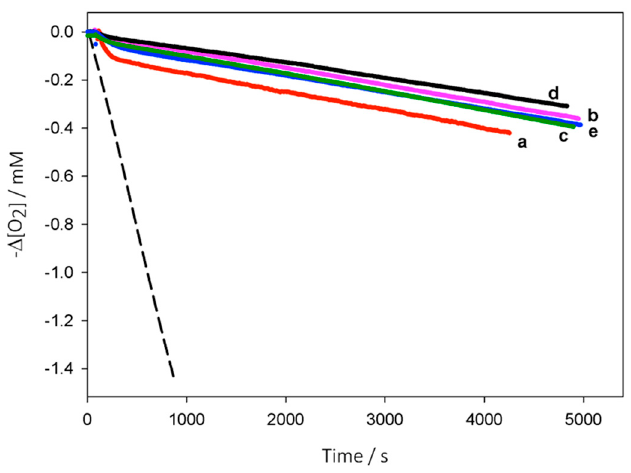
Figure 3. Oxygen consumption during the autoxidation of squalene (1.04 M) initiated by AIBN (0.05 M) in PhCl at 30 °C without inhibitors (dashed) or in the presence of EOs (100 mg/L): red thyme (a), savory (b), clove bud (c), oregano (d), and cinnamon leaves (e).